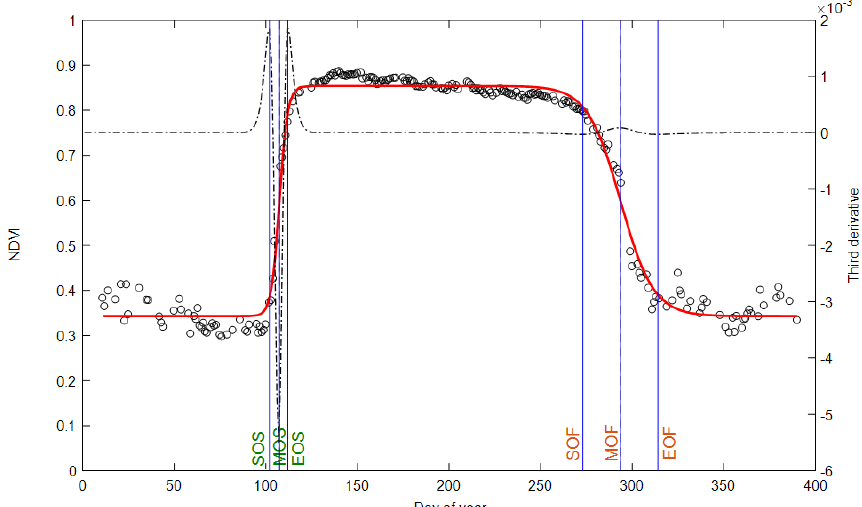
Figure 1. Illustration of phenological markers extracted from ADS (asymmetric double sigmoid) functions fitted to NDVI data acquired in 2015 (empty circles and red curve). Vertical lines in blue: SOS, MOS and EOS are dates of start, middle and end of leaf onset in spring. SOF, MOF and EOF are dates of start, middle and end of leaf senescence (colored and fallen leaves) in autumn. The third derivative of the ADS function shows peaks and holes corresponding to the six phenological dates (black dotted